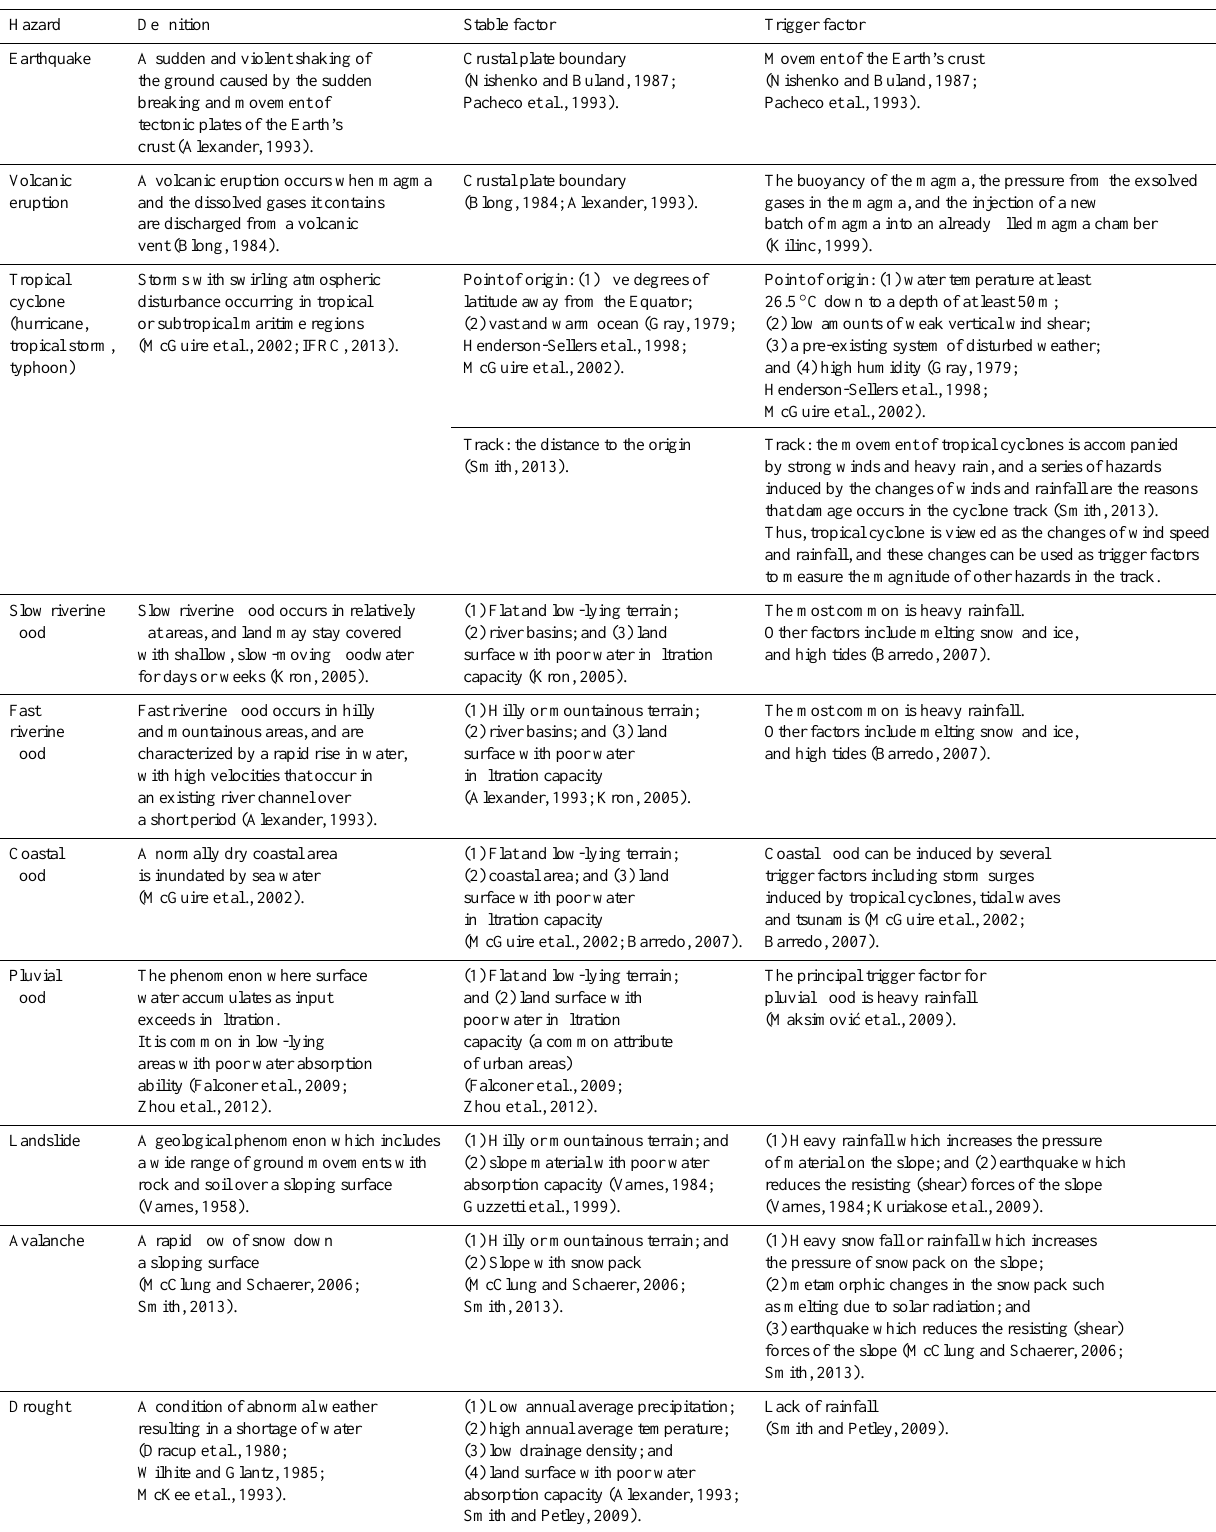
Table 1. The relationship between some specific major hazards and their hazard-forming